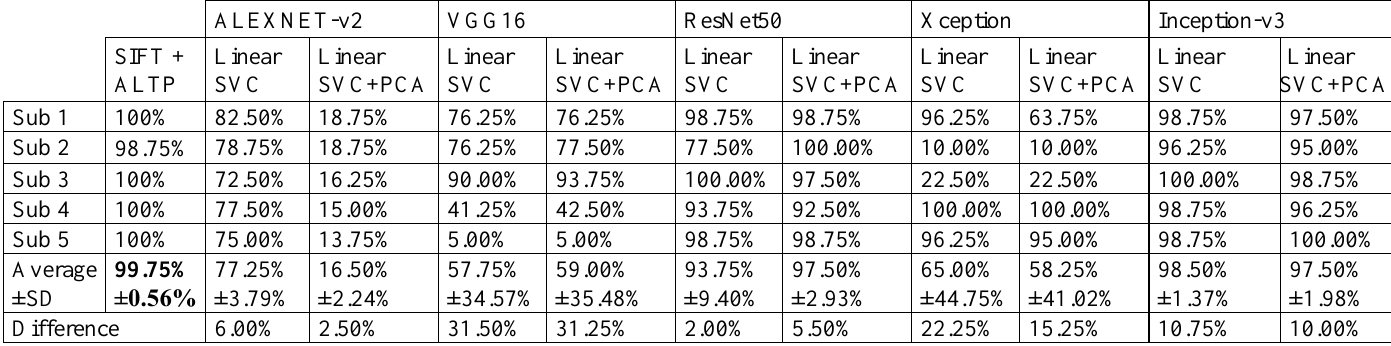
Table 3. Recognition accuracy ratio of SIFT +ALTP method and different deep learning models with data augmentation on the ORL database, and the difference of accuracies with various deep learning models trained without data augmentation.